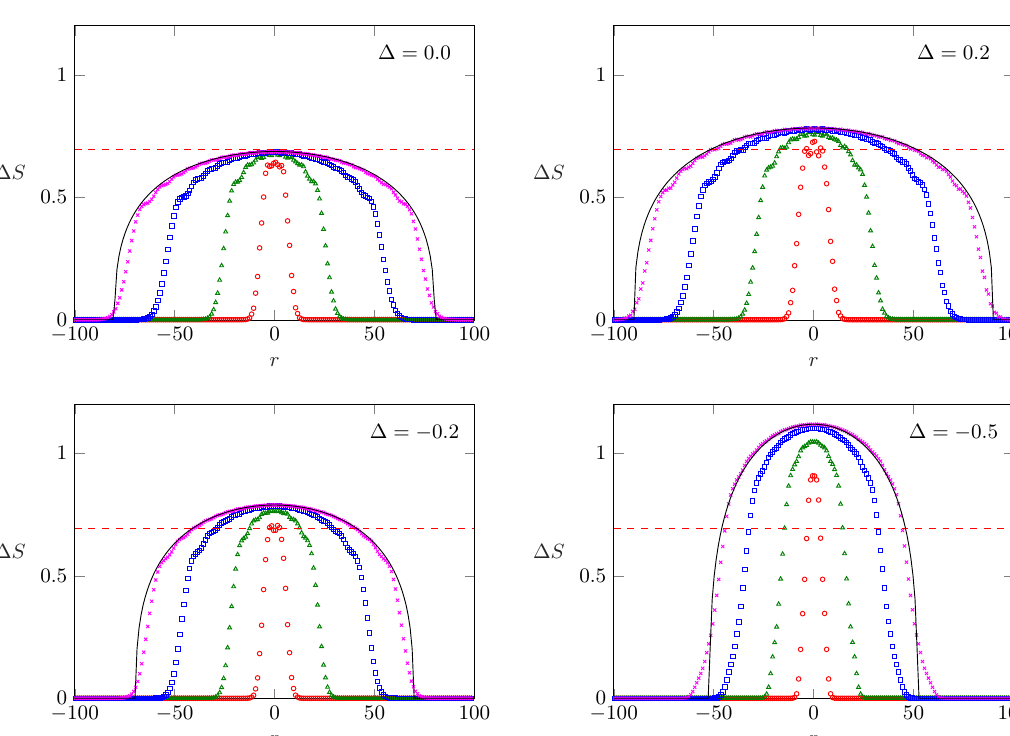
Figure 2: Excess entropy profiles ∆ S as a function of r at times t = 10,30,60,80 (red, green, blue, magenta) after the Majorana excitation m ∆ and L = 200. The red dashed lines indicate the value ln ( 2 ) . The black solid lines show the spinon ansatz Eq. (17) for t = 80, multiplied by a constant to match the maxima of the